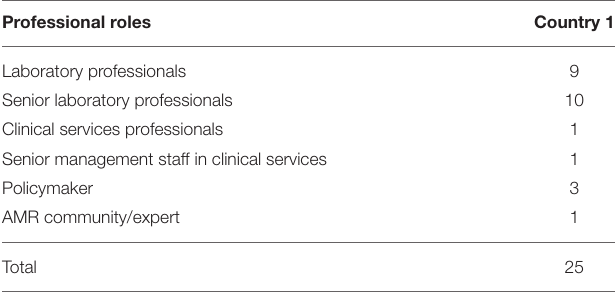
TABLE 1 | Interviews conducted in Country A. Professional